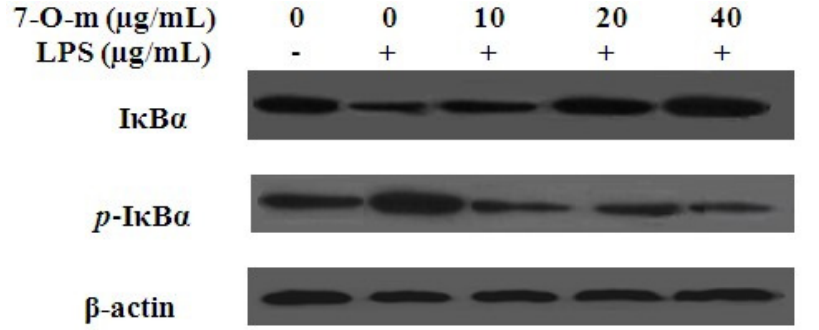
Figure 5. Effect of 7- O -methylnaringenin treatment on I κ B α phosphorylation and degradation. RAW 264.7 macrophage cells were pretreated with the concentrations (10,